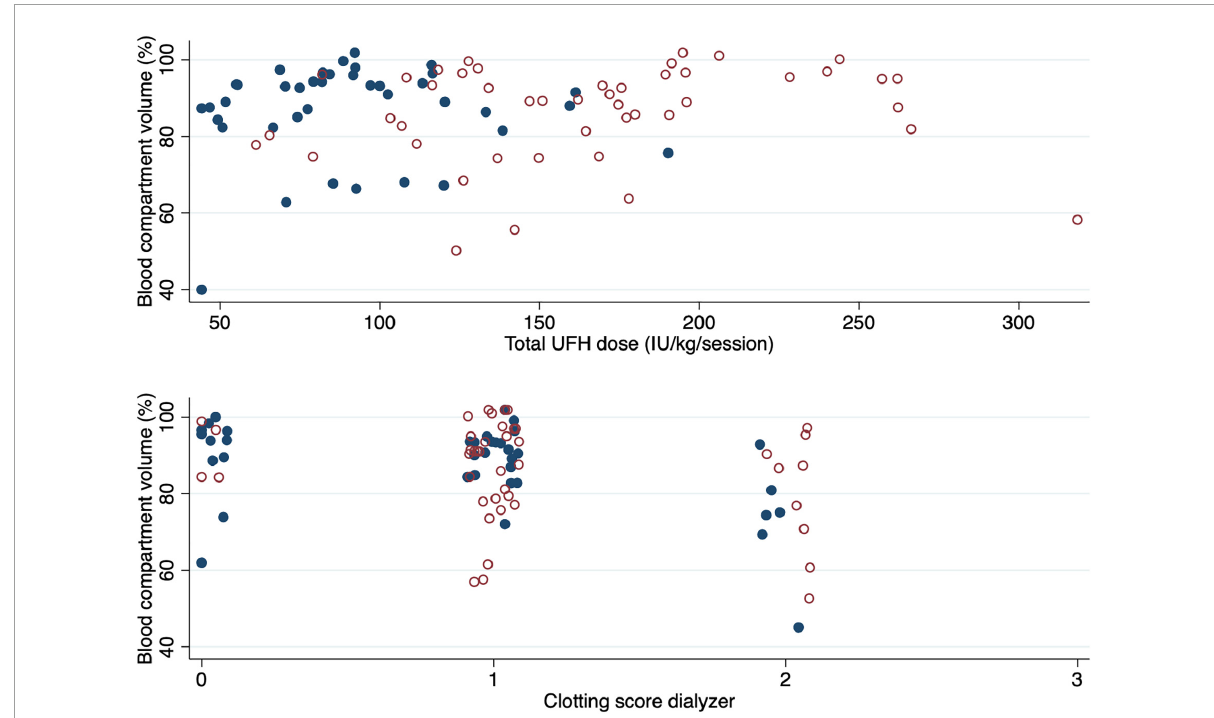
FIGURE6 Relation of blood compartment volumes of used dialyzers with UFH dose and dialyzer clotting score. The blood compartment volume of used dialyzers, expressed as the proportion (%) of the measured volume after use over the theoretical volume, is shown according to the total dose of unfractionated heparin administered during the hemodialysis session (upper panel) and the clotting score of the dialyzer (lower panel). The blue dots represent patients with an arteriovenous fistula or graft, the red circles represent patients with a catheter